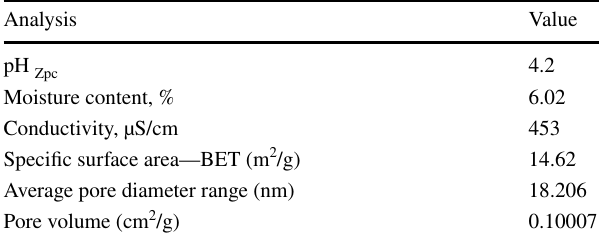
Table 1 Physico-chemical characteristics of